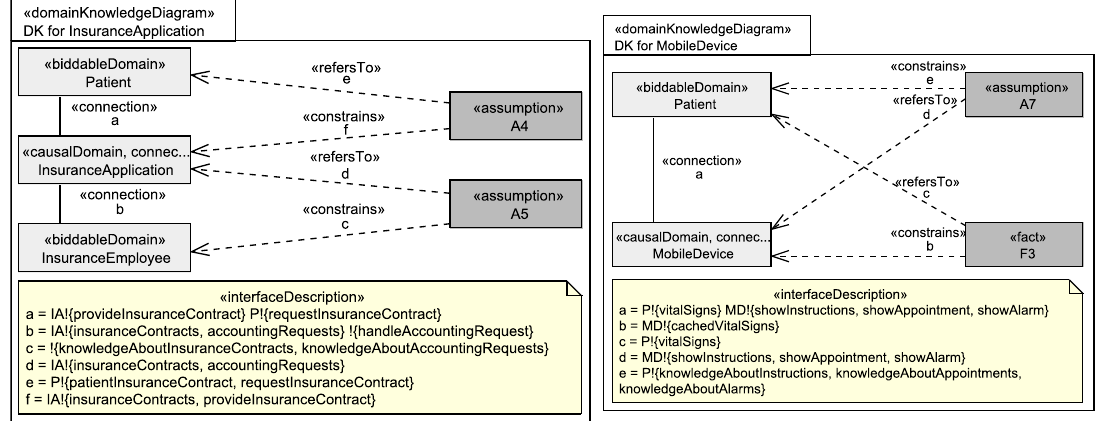
Figure 5. Domain Knowledge about the Insurance Application ( left ) and the Mobile Device ( right